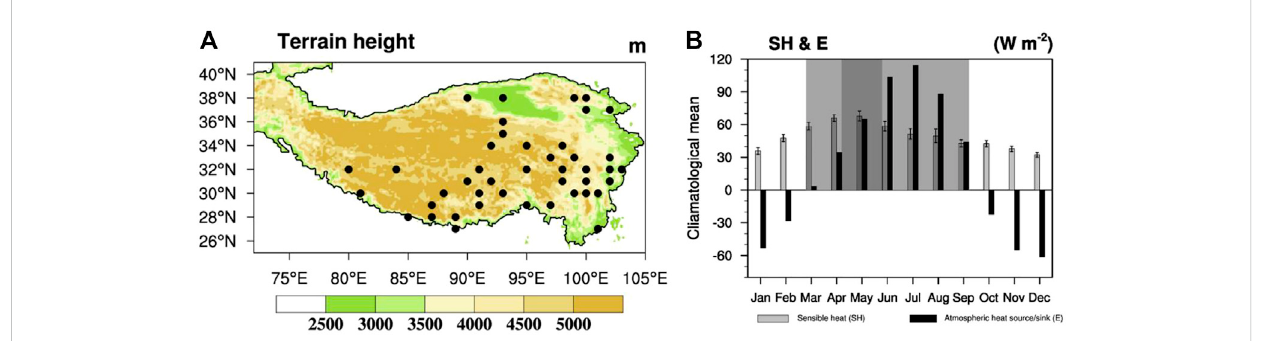
FIGURE 2 (A) Spatial distribution of routine surface China Meteorological Administration (CMA) stations over the TP. Shading indicates the altitude, unit: m; soliddots denote48stationscovering 1979 – 2019. (B) AnnualcycleoftheSHandtheatmosphericheatsource/sink(unit: W · m − 2 )from1979 to 2019 over the TP. The gray bars represent the variation of mean SH, and the black bars represent the change of the mean atmosphericheat source/sink (E) over the TP. The light gray and the dark gray shadows represent months of positive E and maximum SH, respectively.